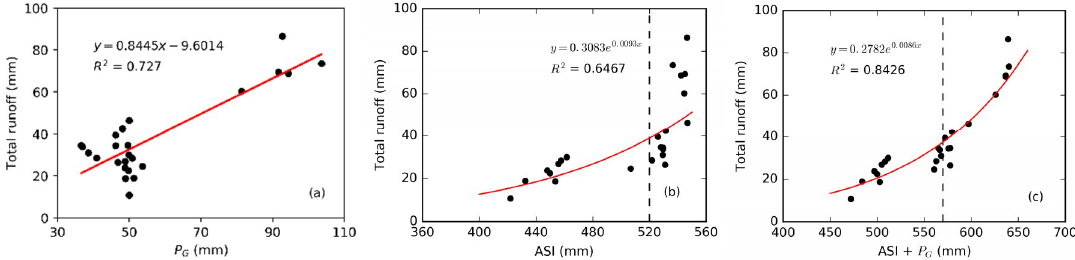
Figure 9. Total runoff (Subsurface runoff + Surface runoff) plotted against three variables, i.e., ( a ) P G (gross precipitation), ( b ) ASI (Antecedent soil moisture index) and ( c ) the sum of ASI and P G.